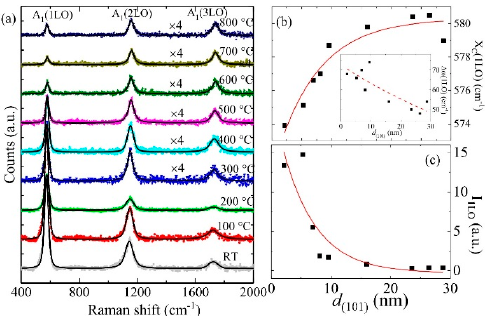
Figure 3. ( a ) Raman spectra of RT and 100 to 800 °C annealed ZnO/ALO films, where the solid line represents the fit using Voigt function; ( b ) The d (101) dependency of peak center of A 1 (1LO) phonon mode where the solid line represents the fit. Inset of the figure shows d (101) dependency of the spectral width Δω (1LO), where the dashed line is a guide for the eye; ( c ) The d (101) dependency of the Raman scattering intensity I 1LO , where the solid line is a guide for the eye.